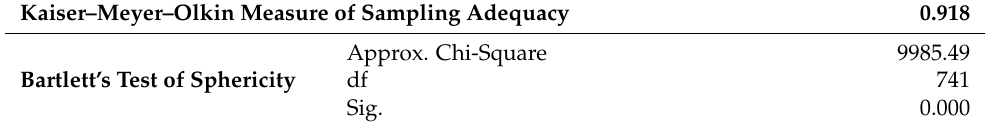
Table 8. KMO and Bartlett’s